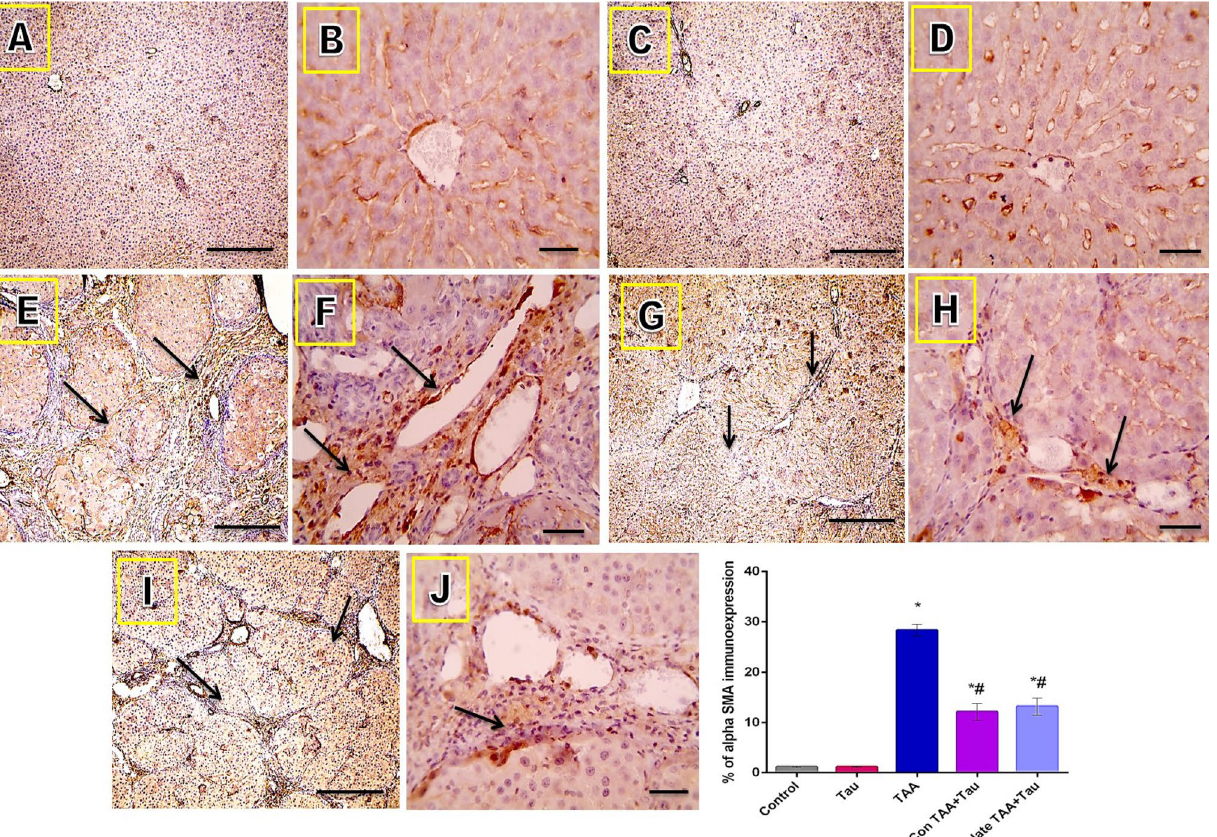
immunoexpression. α-SMA: alpha smooth muscle actin. ( A,C,E,G,I ): X: 100 bar 100., ( B,D,F,H,J ) X: 400 bar 50. *: Significance against control group ( P < 0.05), #: Significance against TAA group ( P <